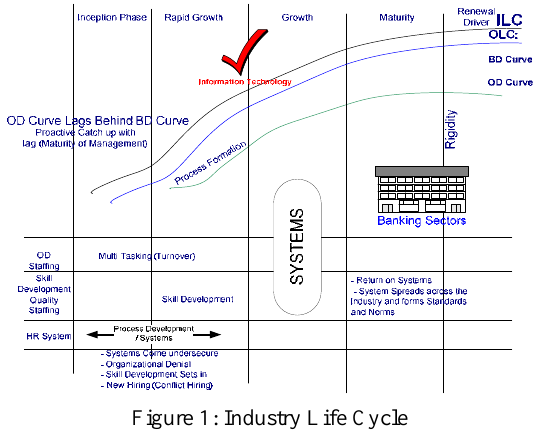
Figure 1: Industry Life